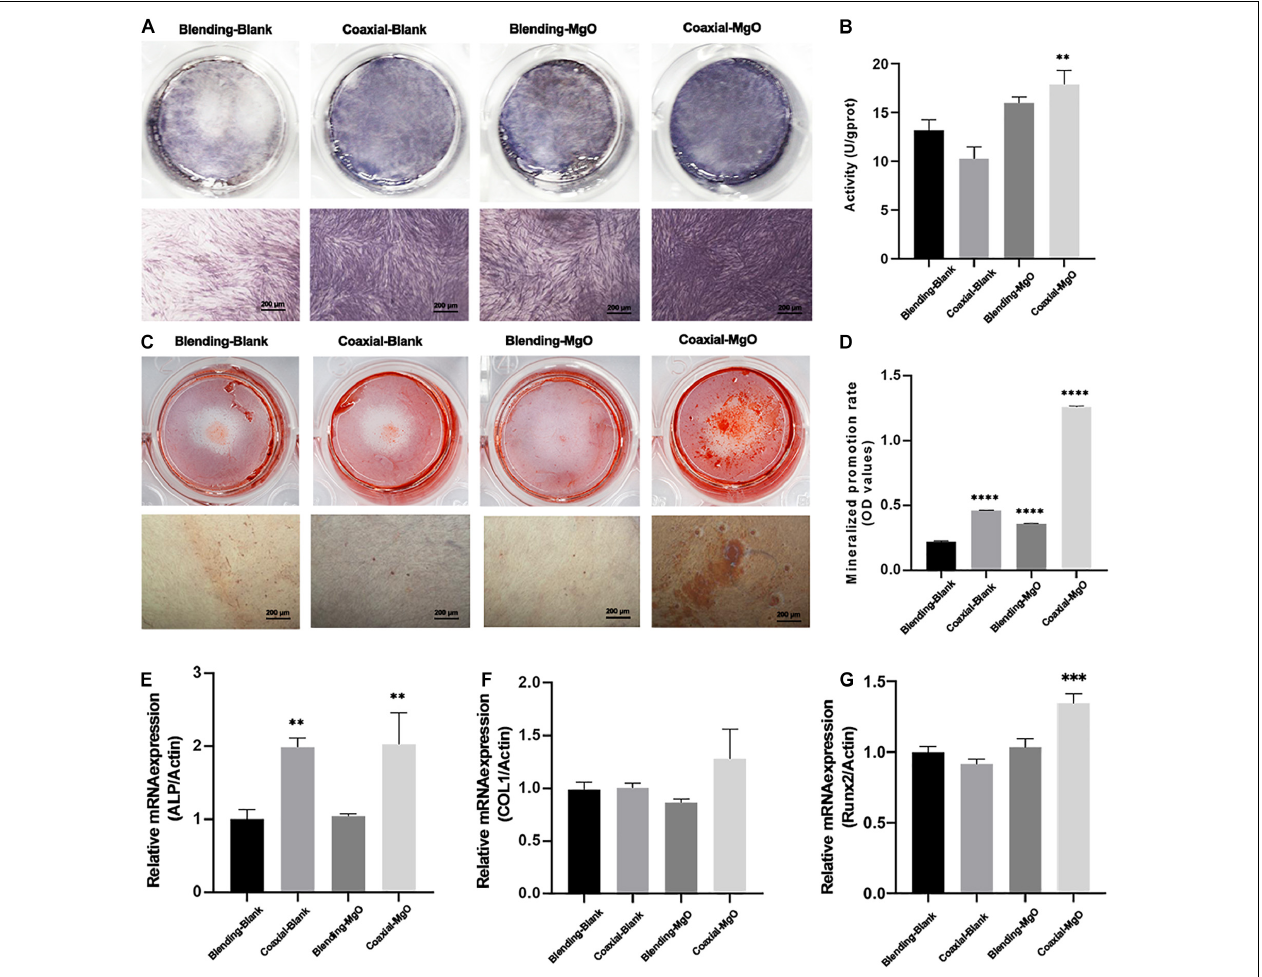
FIGURE 5 | Effects of electrospun membranes on ALP activity and mineralization. (A) ALP staining of hPDLSCs after cultured with electrospun membranes for 7 days. (B) ALP activity level of hPDLSCs cocultured with electrospun membranes on the 7th day. (C) Alizarin red staining of hPDLSCs after seeded on electrospun membranes for 14 days. (D) Mineralized promotion rates of cells cultured with each group of the electrospun membranes. RT-qPCR analysis of (E) ALP, (F) COL1, and (G) Runx-2 expression of hPDLSCs after cultured with electrospun membranes for 3